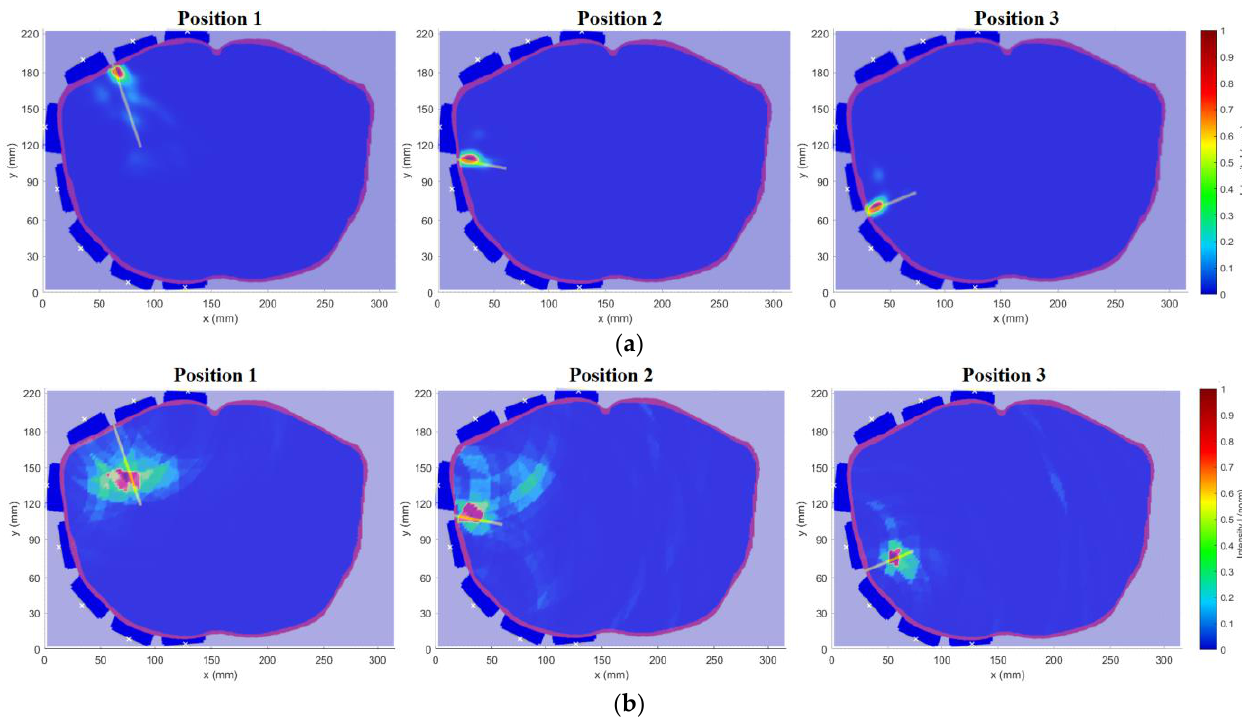
Table 7. Detection accuracy-Comparison of the accuracy achieved within the numerical model and measurement. Position (-)